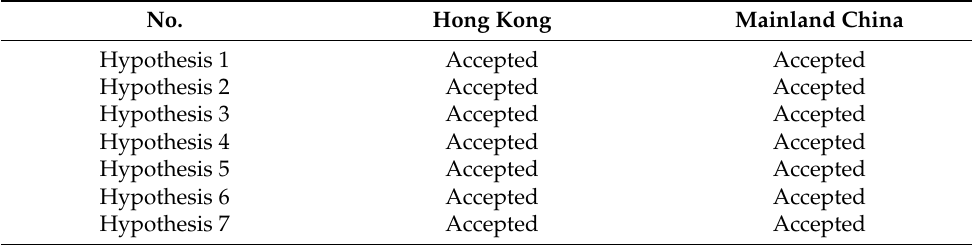
Table 12. Verification results of the hypotheses in safety performance mechanism. No. Hong